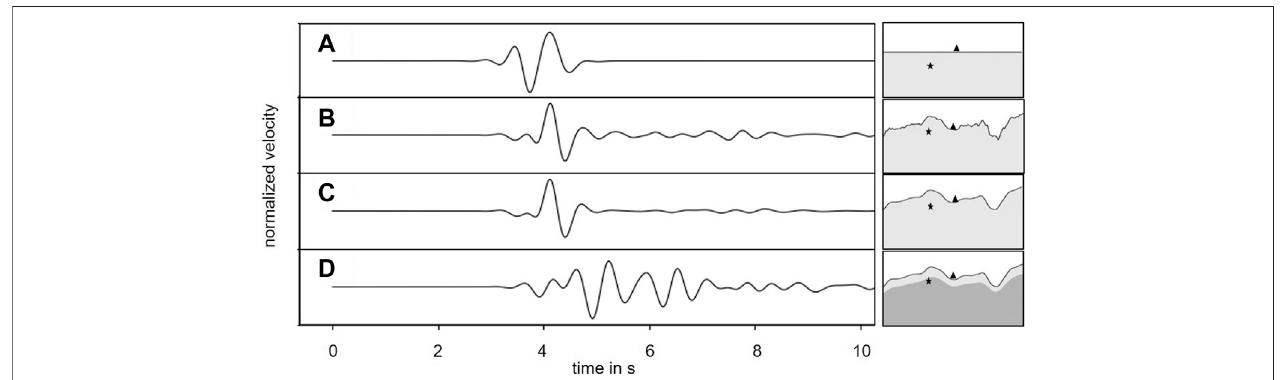
FIGURE 7 | In fl uence of different subsurface models on the synthetic seismogram used for the numerical modeling. Each trace shows the seismogram at the centralarraystationandontherightacrosssectionofthecorrespondingsubsurfacemodelisshown.Thestarmarksthesourcelocation(400 mbelowthedomespeak) and thetrianglemarksthestationpositionat2 kmdistance. (A) Ischaracterizedbya fl at topographyabove ahomogeneous halfspace (model 1). (B) realtopographyas a section through the position of the array and El Caliente. (C) Smoothed topography (model 2). (D) Two layer model with smoothed topography (model 3).